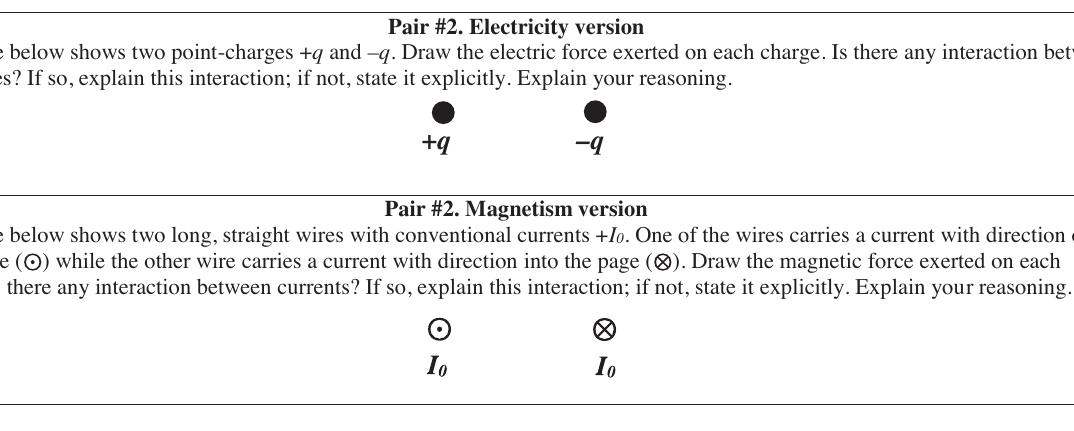
FIG. 3. Pair No. 2 of parallel items. In the electricity version ( E ), two static opposite charges of the same magnitude are presented. The magnetism version ( M ) presents two long cables with opposite conventional electric currents I 0 , one going out of the page and the other going into the